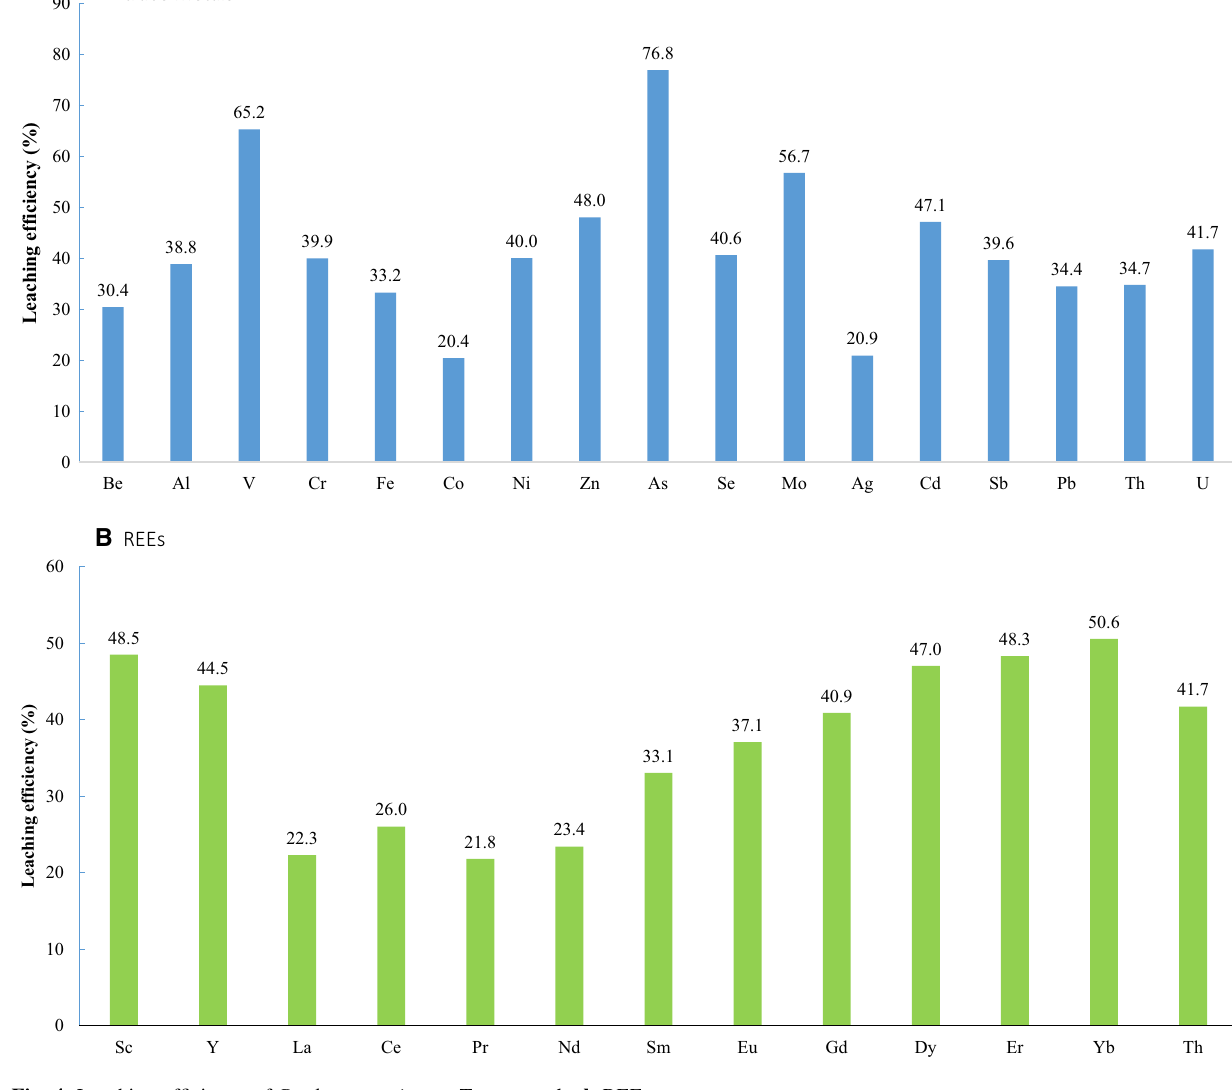
Fig. 4 Leaching efficiency of P. chrysosporium . a Trace metals; b